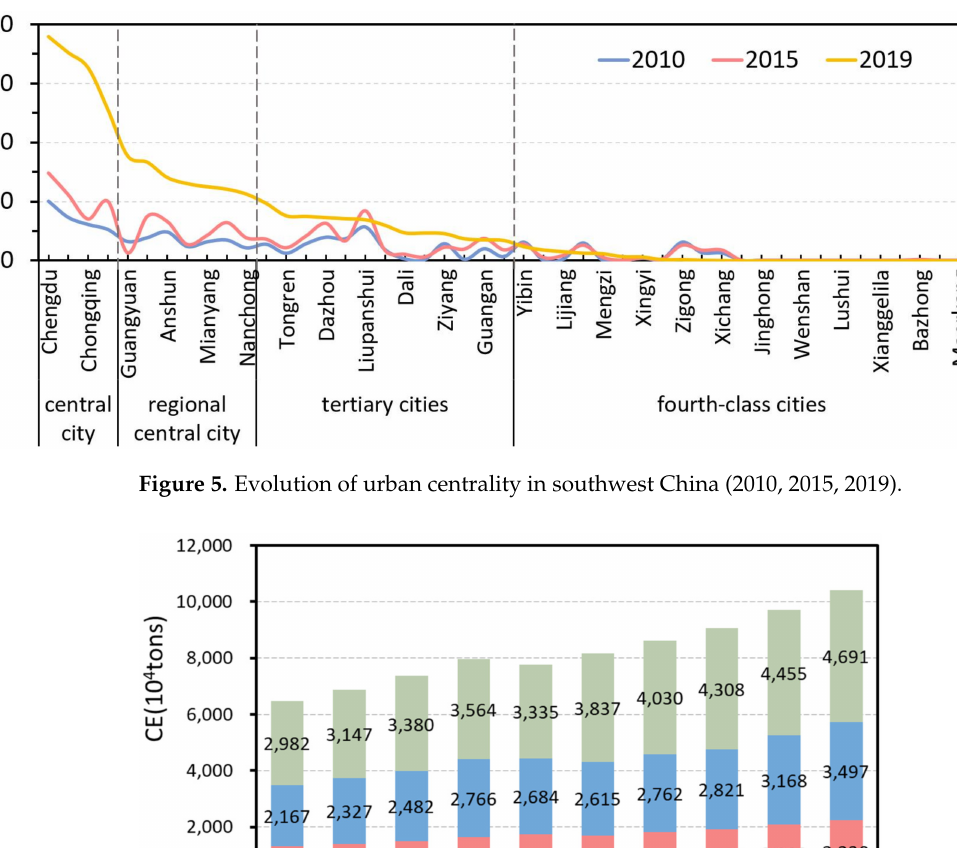
Figure 4. ( a ) Urban networks in southwest China in 2019. ( b ) Carbon emissions in southwest China in 2019.